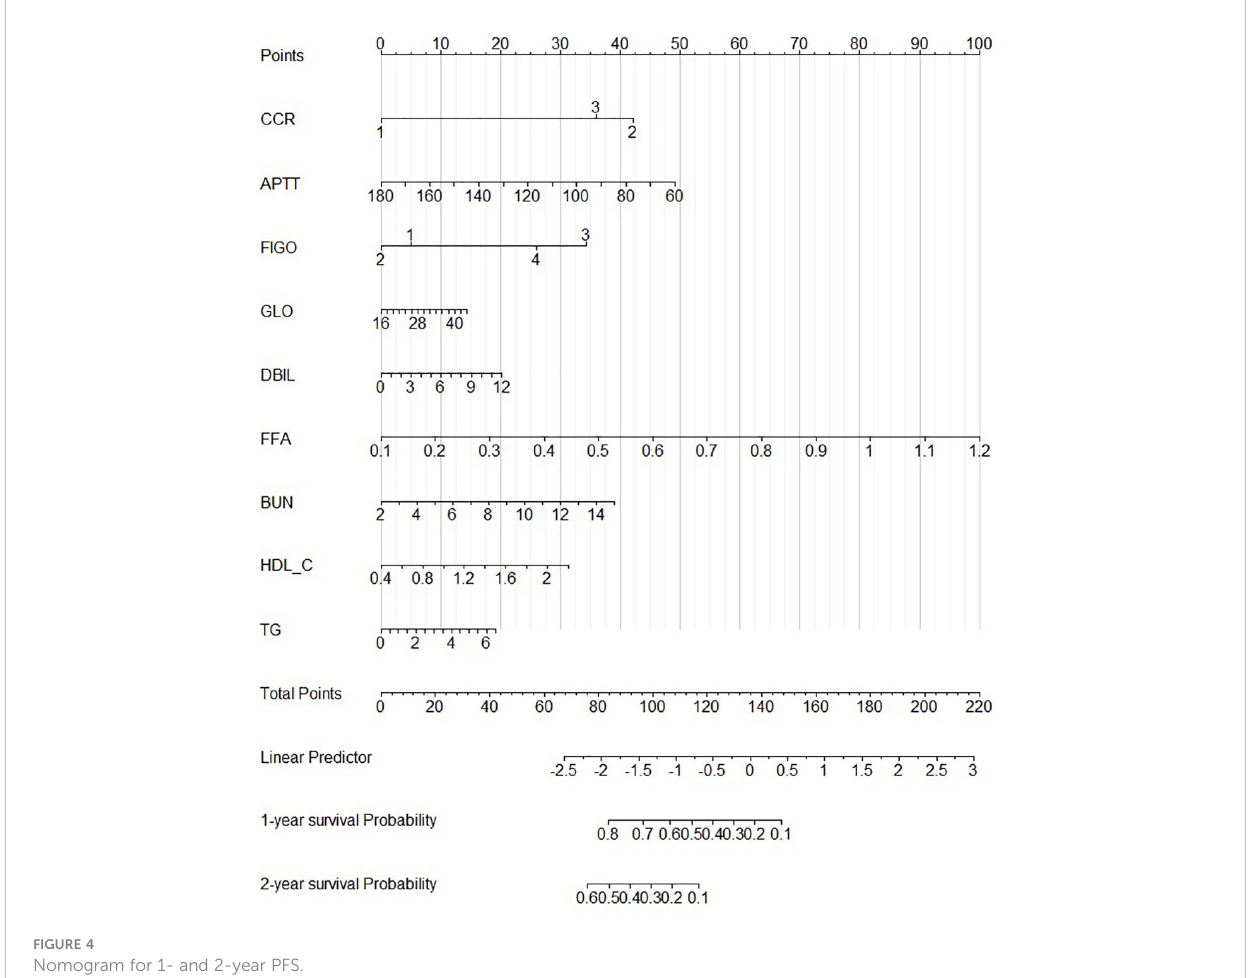
FIGURE 4 Nomogram for 1- and 2-year